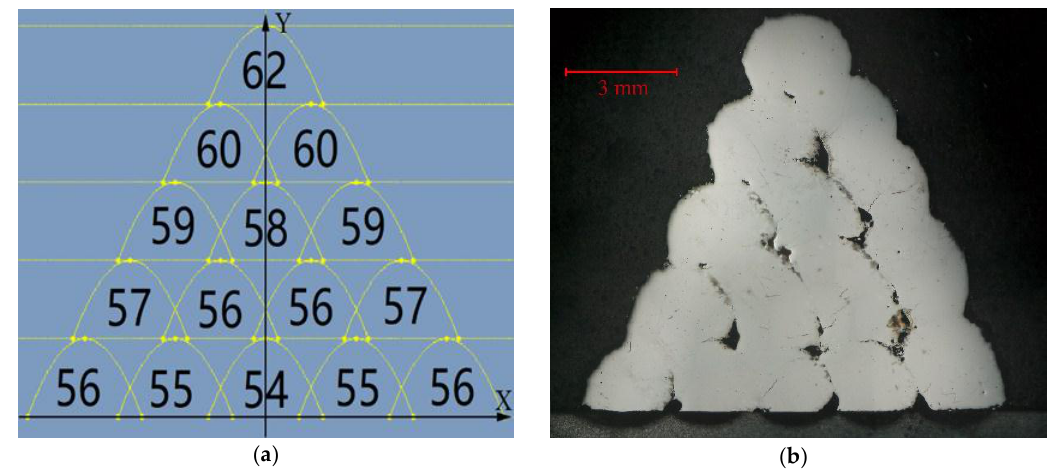
Figure 3 . ( a ) Hardness gradient distribution; ( b ) Two-dimensional hardness gradient cladding layer.